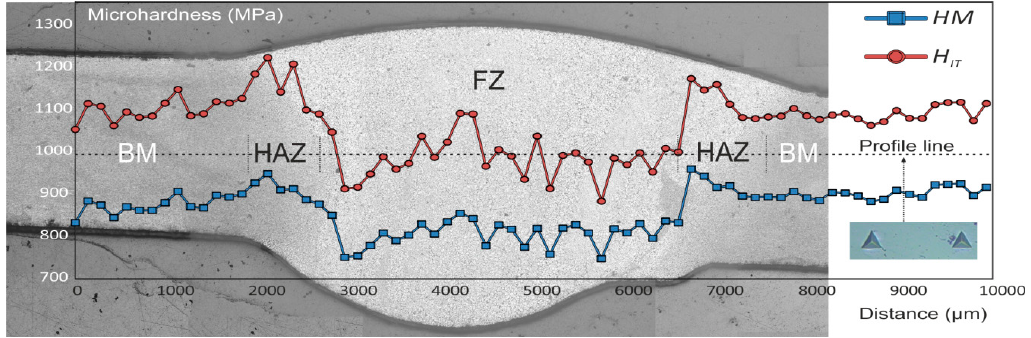
Figure 11. Universal microhardness ( HM ) and Indentation Hardness ( H IT ) distribution along BM, HAZ, and FZ of the welded joint. Materials 2018 , 11 , x FOR PEER REVIEW 12 of 19